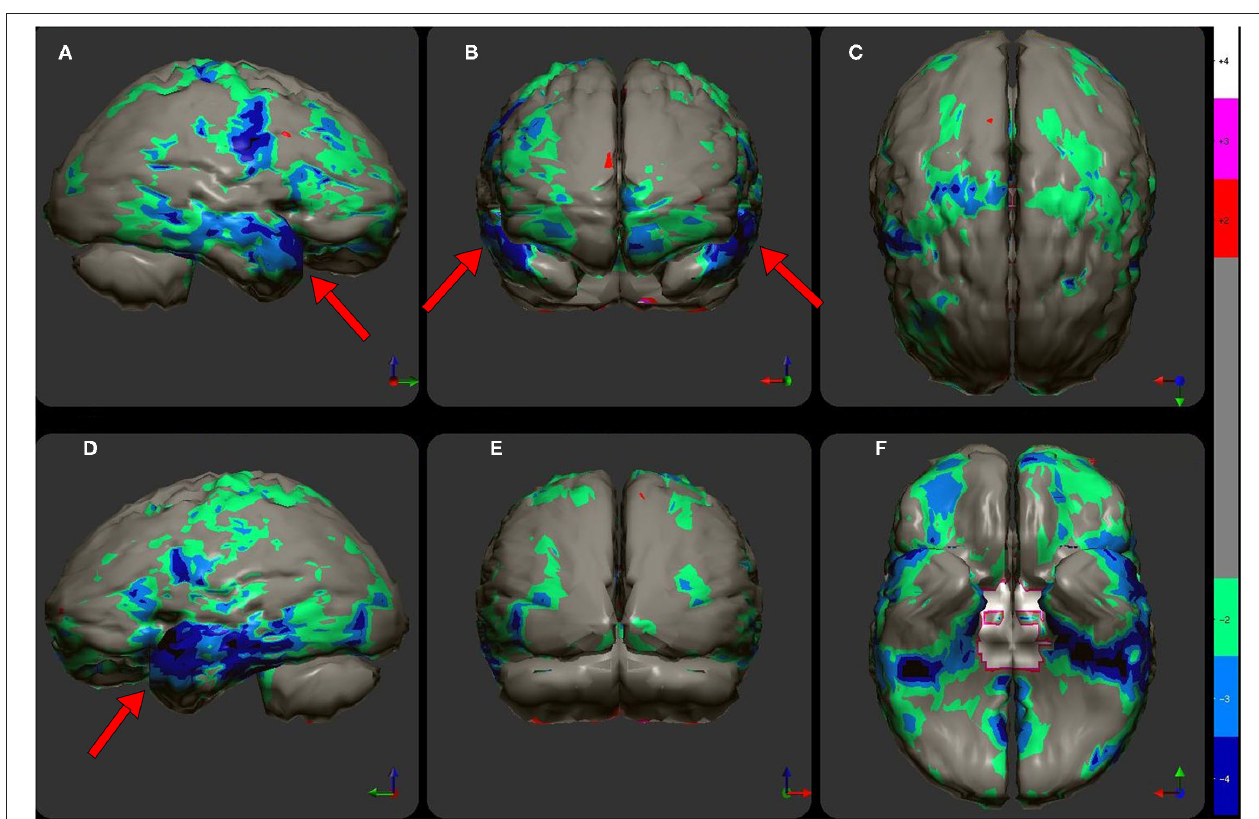
FIGURE 10 | The patient’s data is compared to a normative database ( N = 68). A map of statistically significant differences can be generated using the Oasis software by Segami, Inc. Here, the color scale indicates gray for areas that do not differ significantly from the normative database. In contrast, areas of green, light blue, and dark blue represent areas of more than 2, 3, and 4 SD below the mean perfusion of the normative database, respectively. Statistically significant increases in perfusion are illustrated in the red color scale. Decreased perfusion in the bilateral temporal cortex and bilateral orbitofrontal cortex can be appreciated. Map is displayed in the following views: (A) right lateral, (B) frontal, (C) superior, (D) left lateral, (E) posterior, and (F) inferior with cerebellum removed.